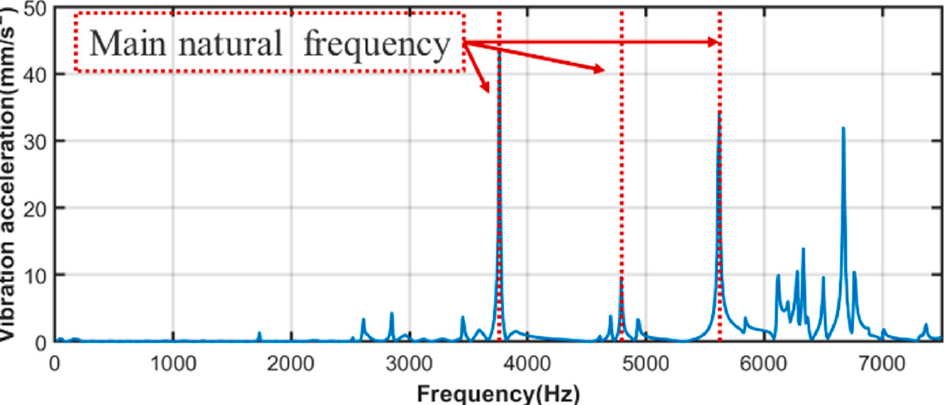
Figure 12. Simulation results of vibration acceleration on shell surface.